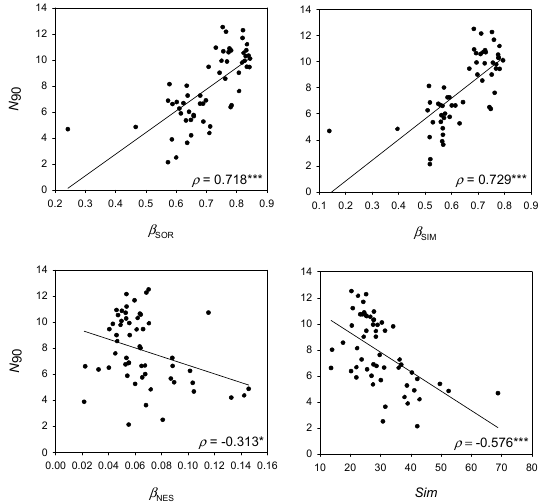
Figure 4. Results of the linear regressions analysis of N 90 with measures of beta diversity β SOR , β SIM and β NES and within-group similarity ( Sim ), considering the whole bathymetric range (50–800 m depth). Spearman’s rank correlation coefficient ( ρ ) and p -values are presented. (*) p < 0.05; (**) p < 0.01; (***) p < 0.001. The stratum showing the highest values of nestedness was middle slope (501–800 m depth; β NES = 0.095). For this stratum, N 90 showed a positive correlation with the gamma version of S ( ρ = 0.820; Figure 5), H’ ( ρ = 0.586; Figure 5) and H 1 ( ρ = 0.586; Figure 5), and the alpha version of S ( ρ = 0.801; Figure 5), H 1 ( ρ = 0.823; Figure 5) and H’ ( ρ = 0.605; Figure 5); and a negative correlation with β NES ( ρ = − 0.627; Figure 6).